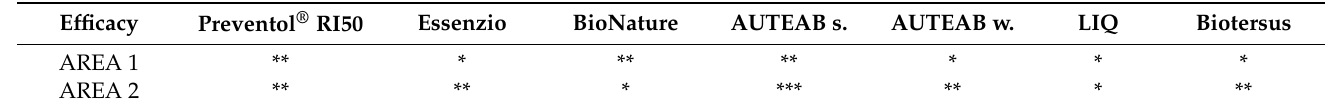
Table 6. The level of efficacy of each biocide treatment for Area 1 and Area 2. * indicates low effectiveness, ** medium efficacy, and *** strong action.